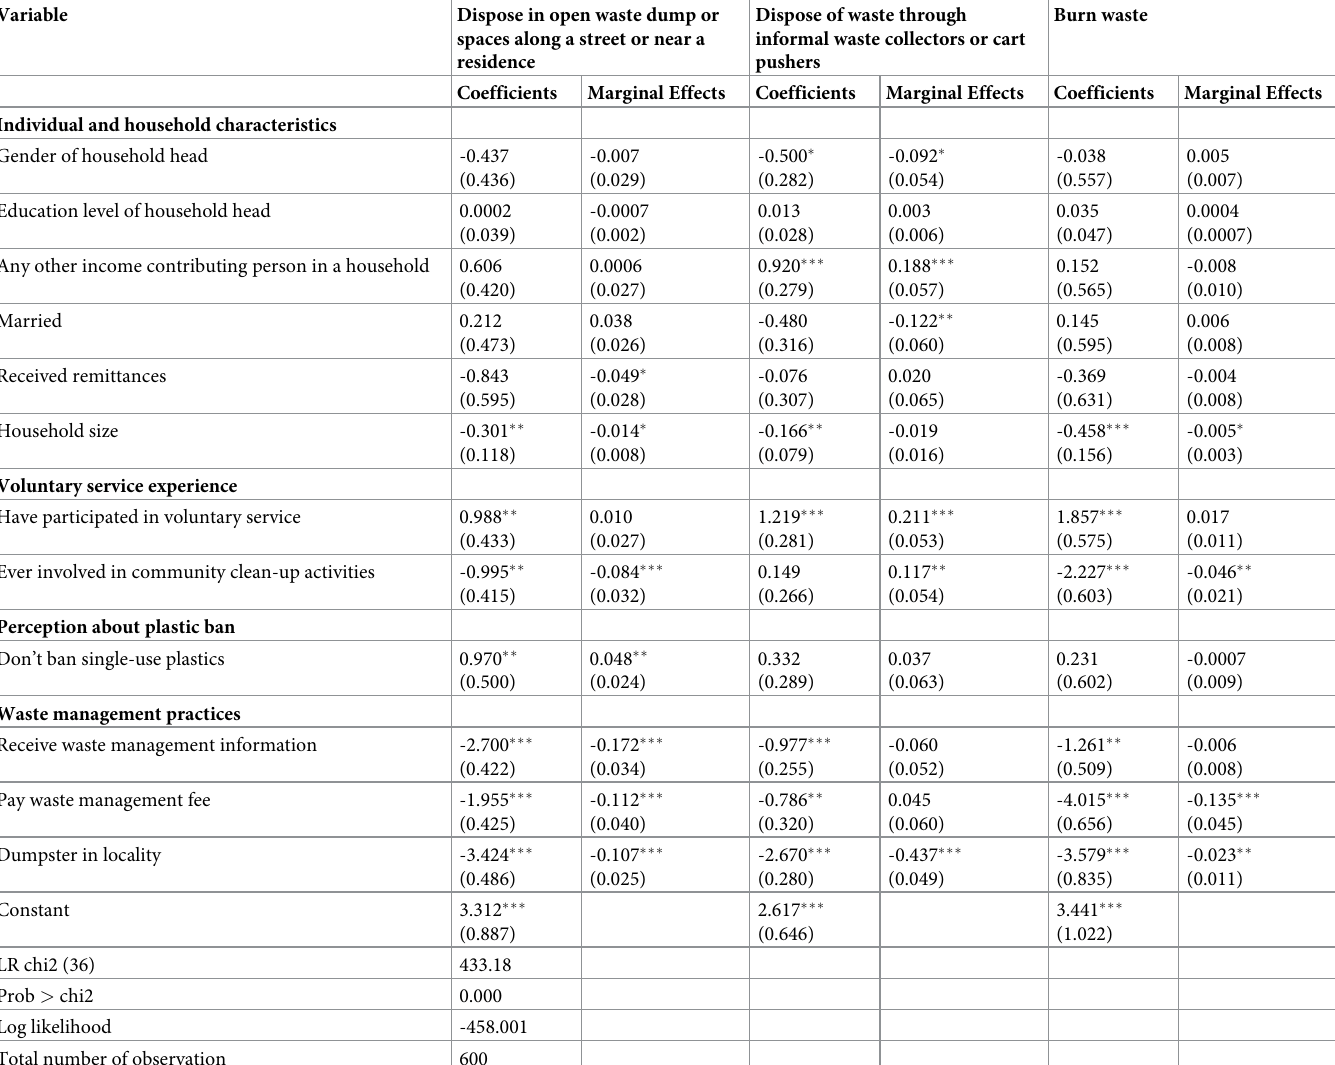
Table 3. Result of MNL- determinants of waste disposal approach employed by the